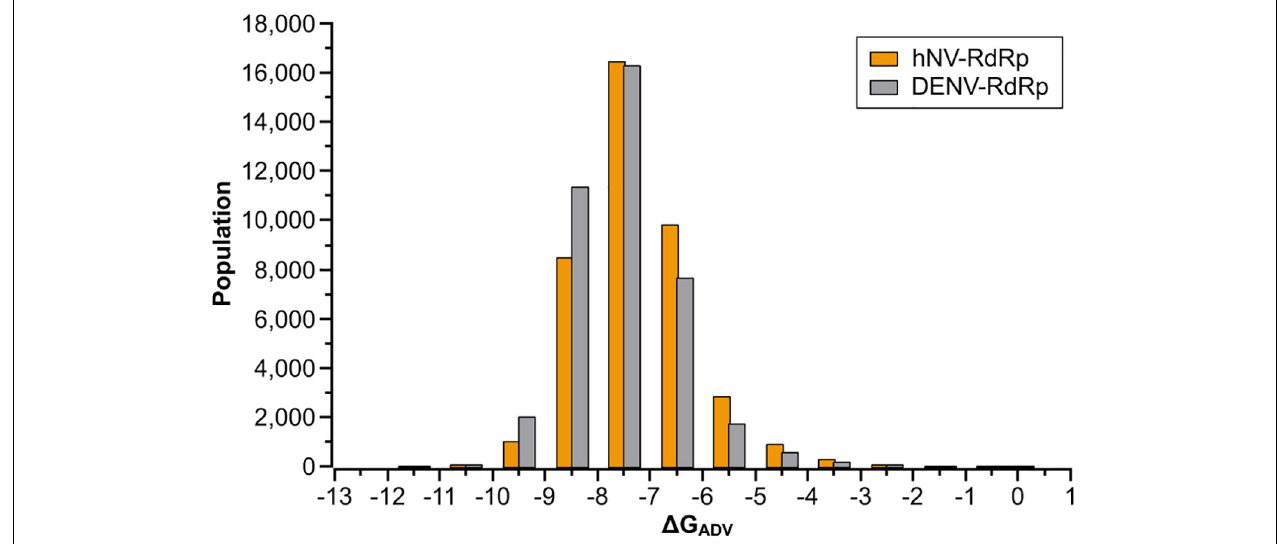
FIGURE 3 | Results of the virtual screening of the TargetMol Database against DENV and hNV RdRps. Bars represent numbers of compounds with predicted free energies of binding in the indicated 1 kcal/mol bins. TABLE 1 | The Database ID, molecule name (MolName), CAS, molecule weight (MW), and calculated binding energies [ (cid:52) G ADV (kcal/mol)] of the selected 20 compounds from structure-based virtual screening. No.